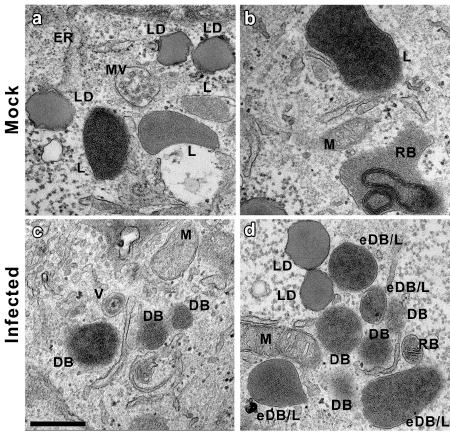
ER—-endoplasmic reticulum, G—-Golgi apparatus. Bars: 500 nm.